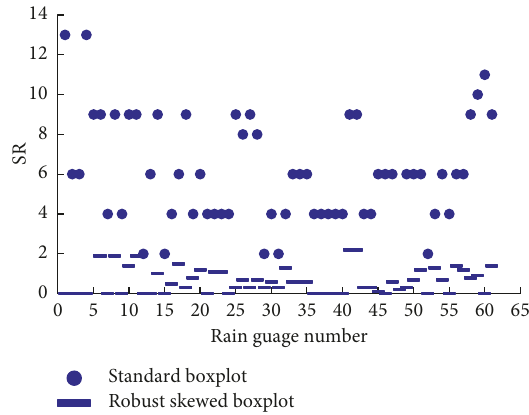
Figure 5: The average SR of each rain